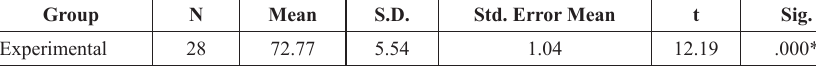
Table 4. Analysis of post-tests of mathematical conceptual understanding compared with the required